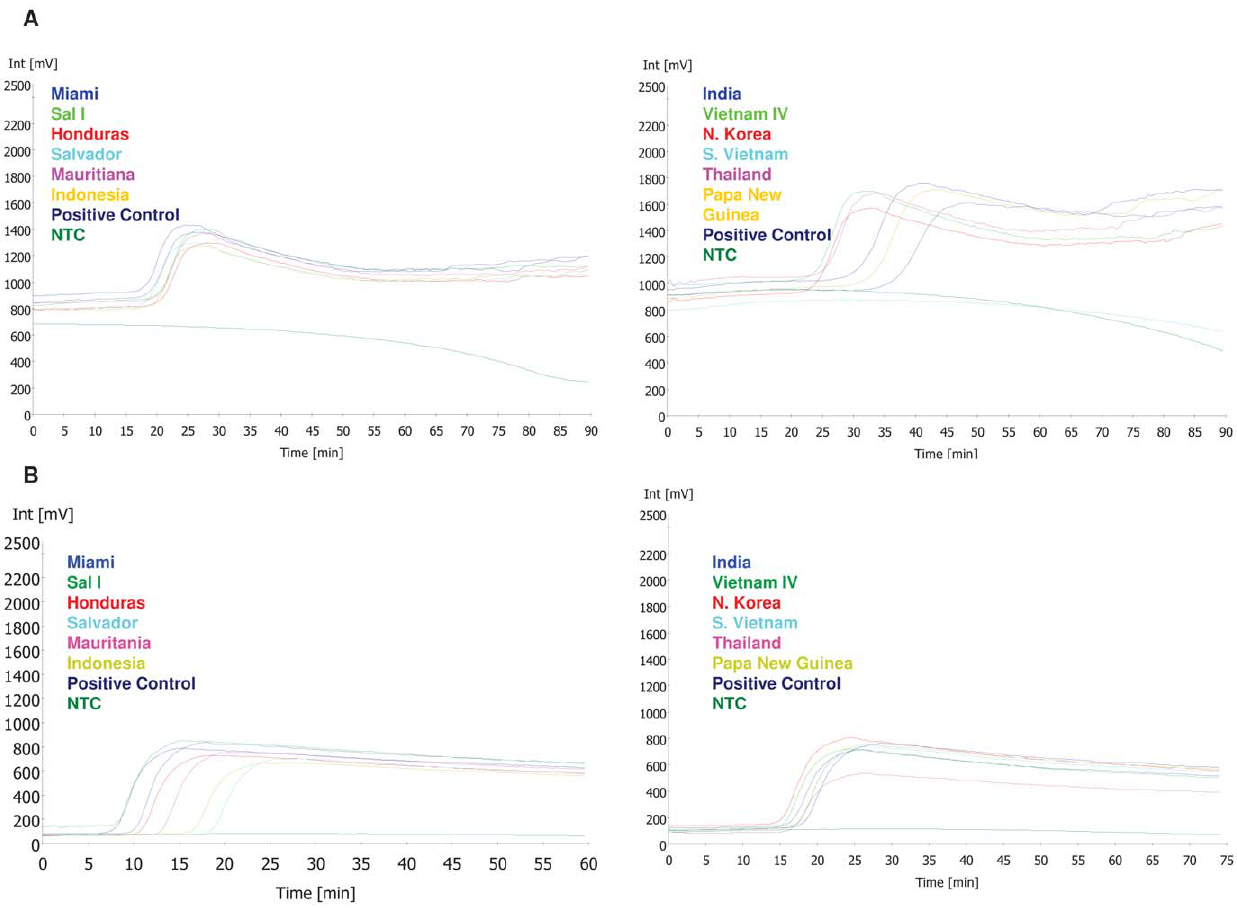
Figure 1. Amplification plots for P.vivax strains from different geographic locations using the r64 primer set with SYBR green (A) and SYTO-9 (B). Amplification plots from P. vivax strains from Pakchong, Chesson and Panama are not shown. Amplification of the template DNA measured in millivolts (mV) on y-axis over time on x-axis. Any amplification observed after 60 minutes of test time was considered negative. A known P. vivax DNA sample was used as the positive control. NTC; No Template Control.